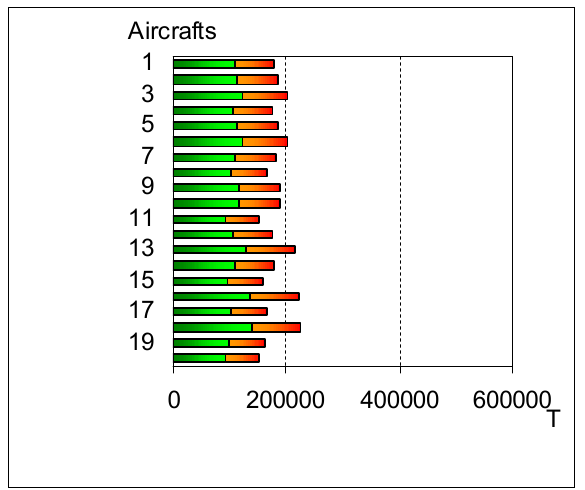
Fig 4. Bar chart of CUCDTP for the corroded specimens at 5%